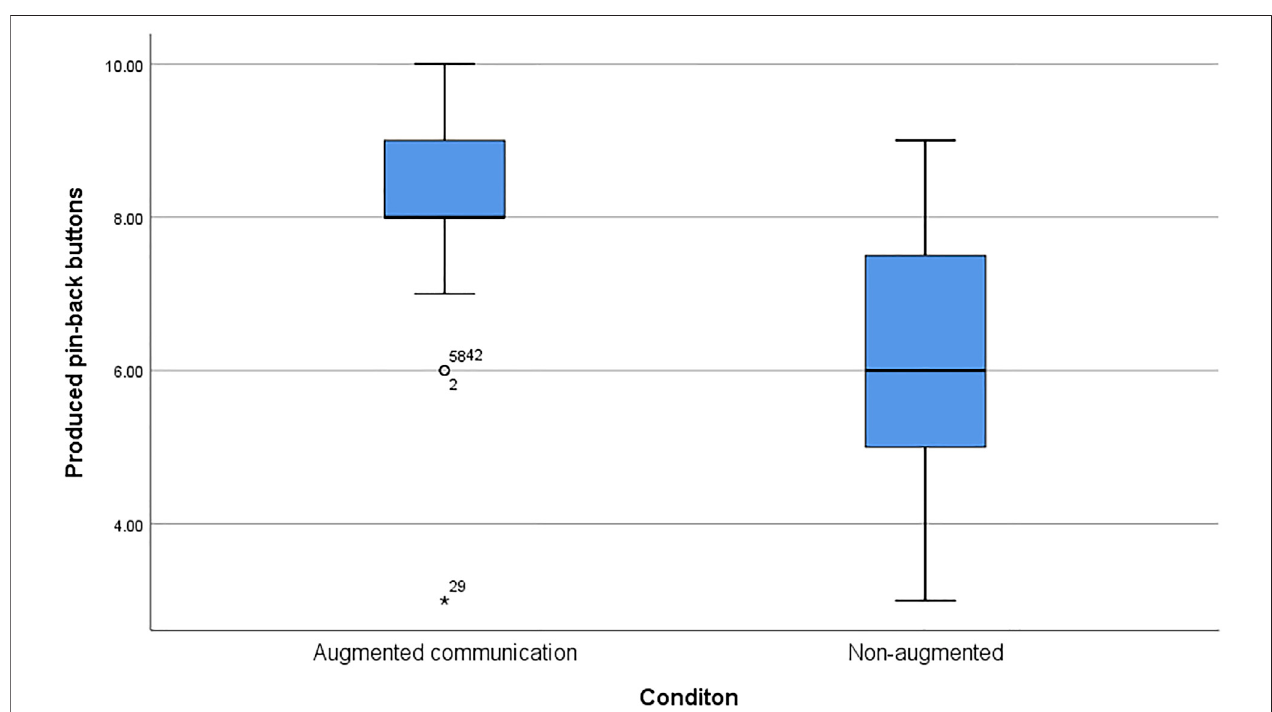
FIGURE8| Thechartpresentstheaveragenumberofpin-backbuttonsproducedbytheparticipantsincollaborationwiththerobotarm.Theaugmentedcondition ( M (cid:1) 8.20, SD (cid:1) 1.40) resulted in a higher production output than the non-augmented condition ( M (cid:1) 6.15, SD (cid:1) 1.53).